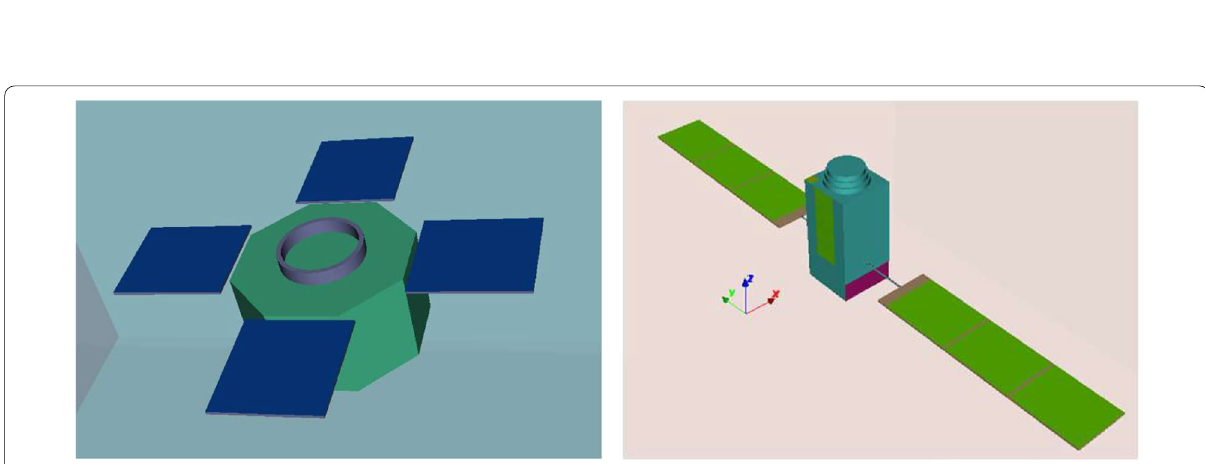
Fig. 5 Geometric models of Van Allen Probes (left) and Michibiki‑1 satellite